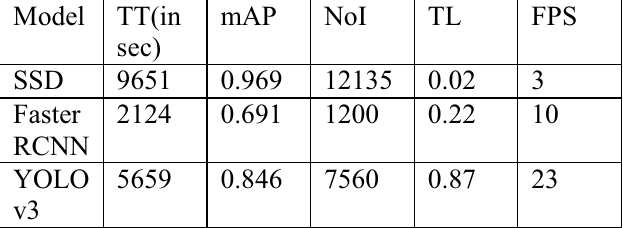
Table 1: Comparison of different object detection